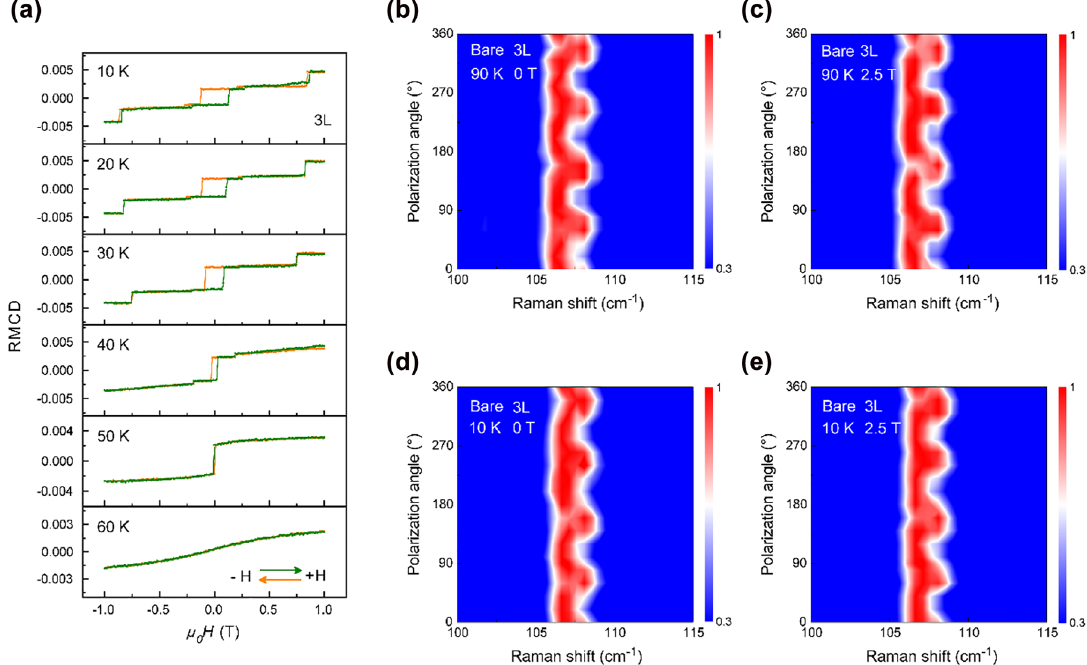
. The magnetic 3 collected at 0 and 2.5 T at 3